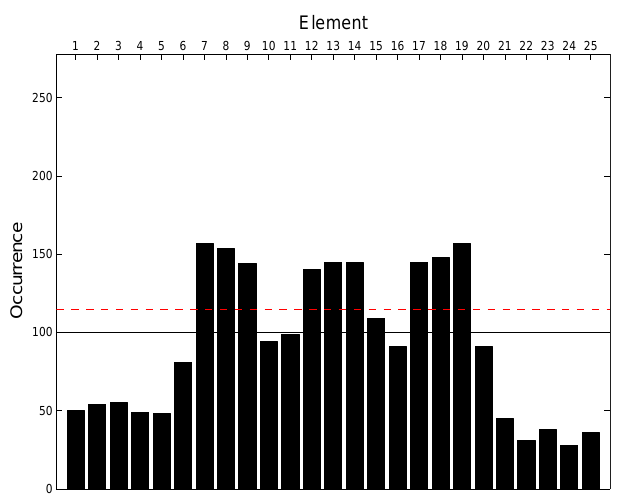
Fig. 8. Performance of the hotspot detection algorithm for system 3 with additive noise using time series of 2000yr. The frequencies show the number of times a particular element remains until the end of the selection process for 500 repetitions. Each repetition in- volves the generation of a new time series and its analysis with the hotspot detection algorithm. The solid black line marks the expec- tation value for a random selection where all elements are selected with equal probability. The red dashed line marks the 95% probabil- ity threshold of the corresponding cumulative binomial distribution. Parameter settings correspond to set 1 in Table